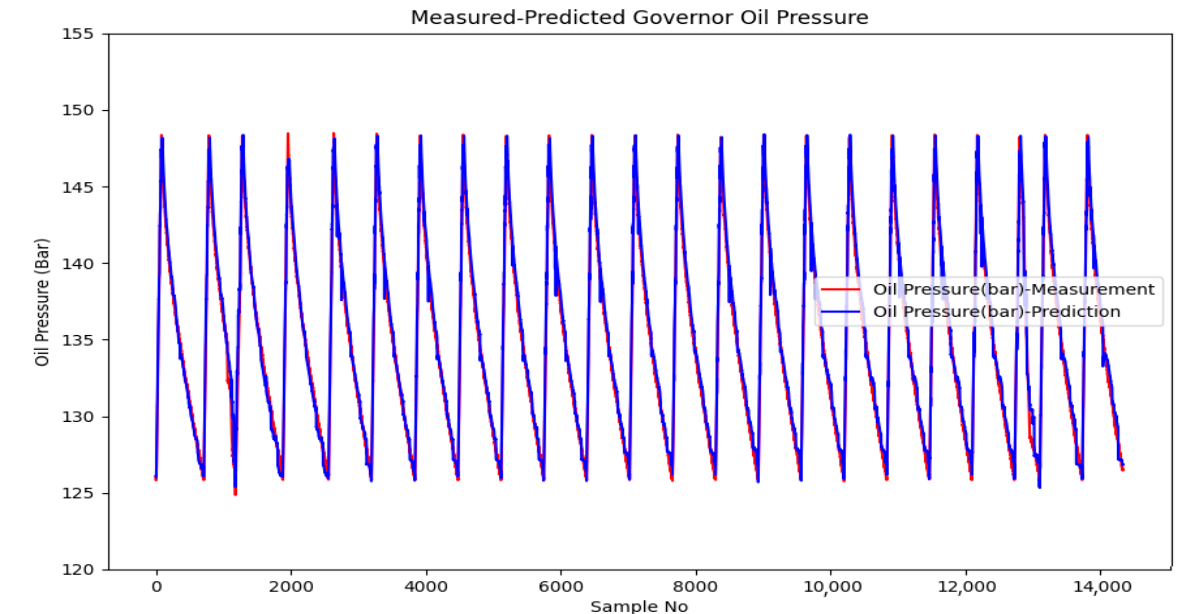
Figure 19. Predicted-measured governor system pressure.